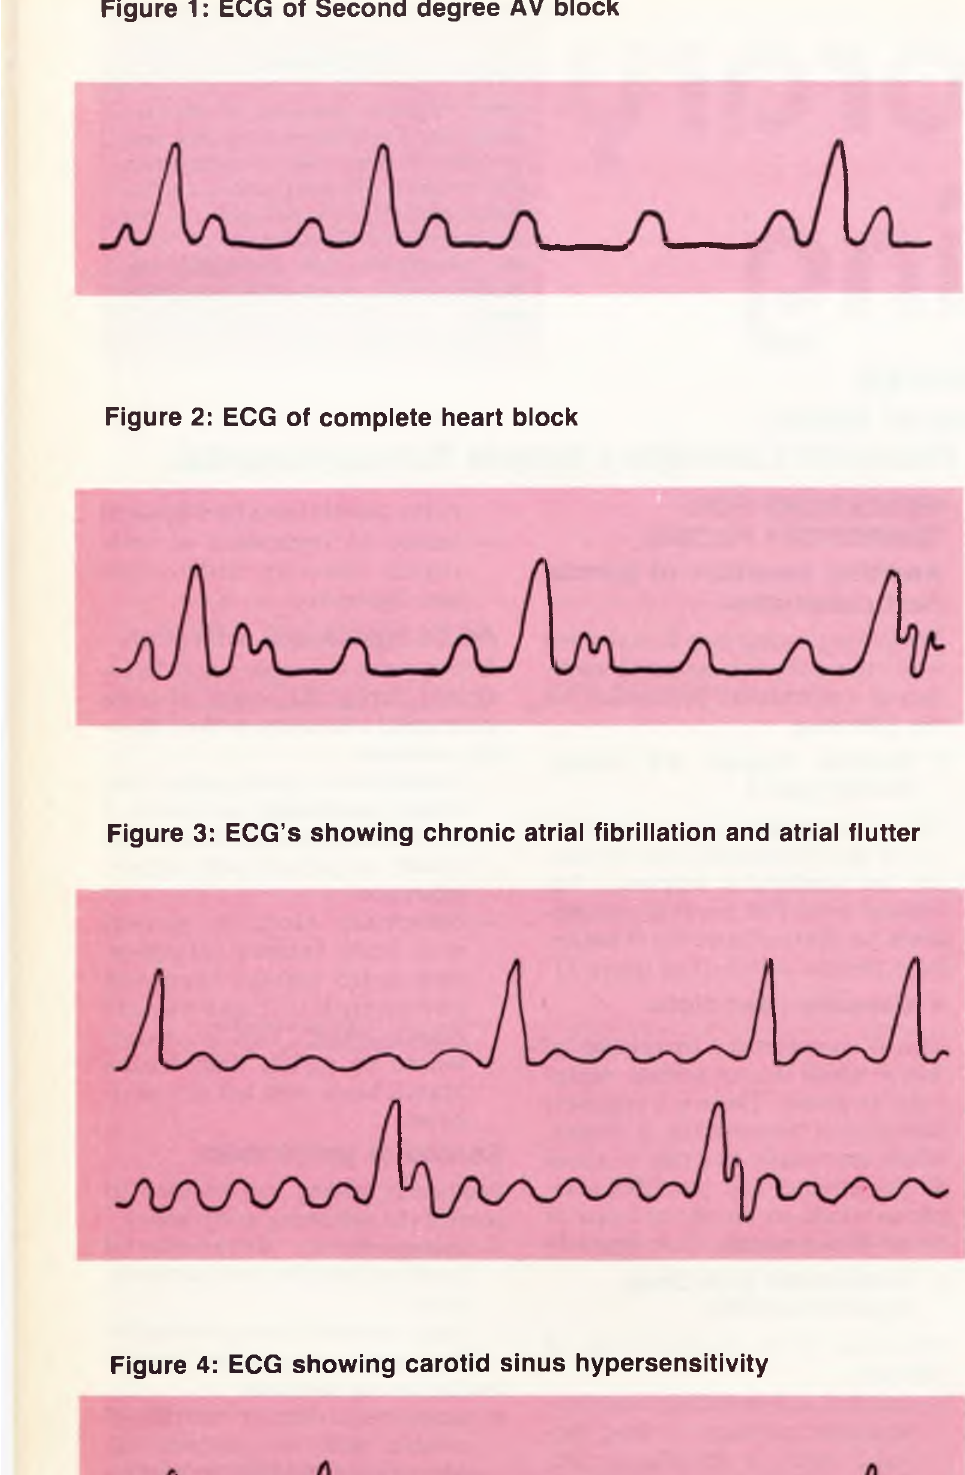
Figure 1: ECG of Second degree AV block